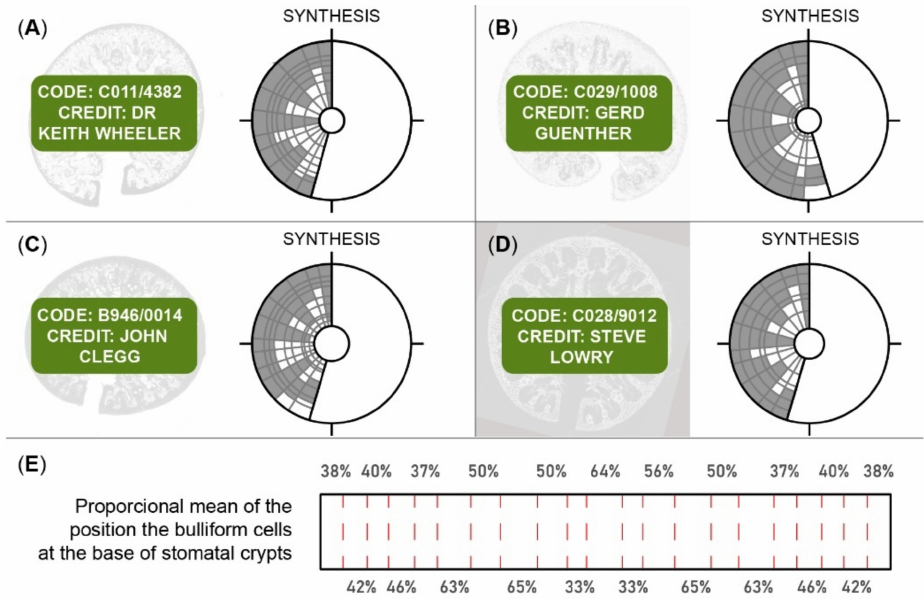
Figure 11. Schematic diagram of the cross-section analysis ( A – E ). Source: images cross-section [35]; Schematic diagram. Source: